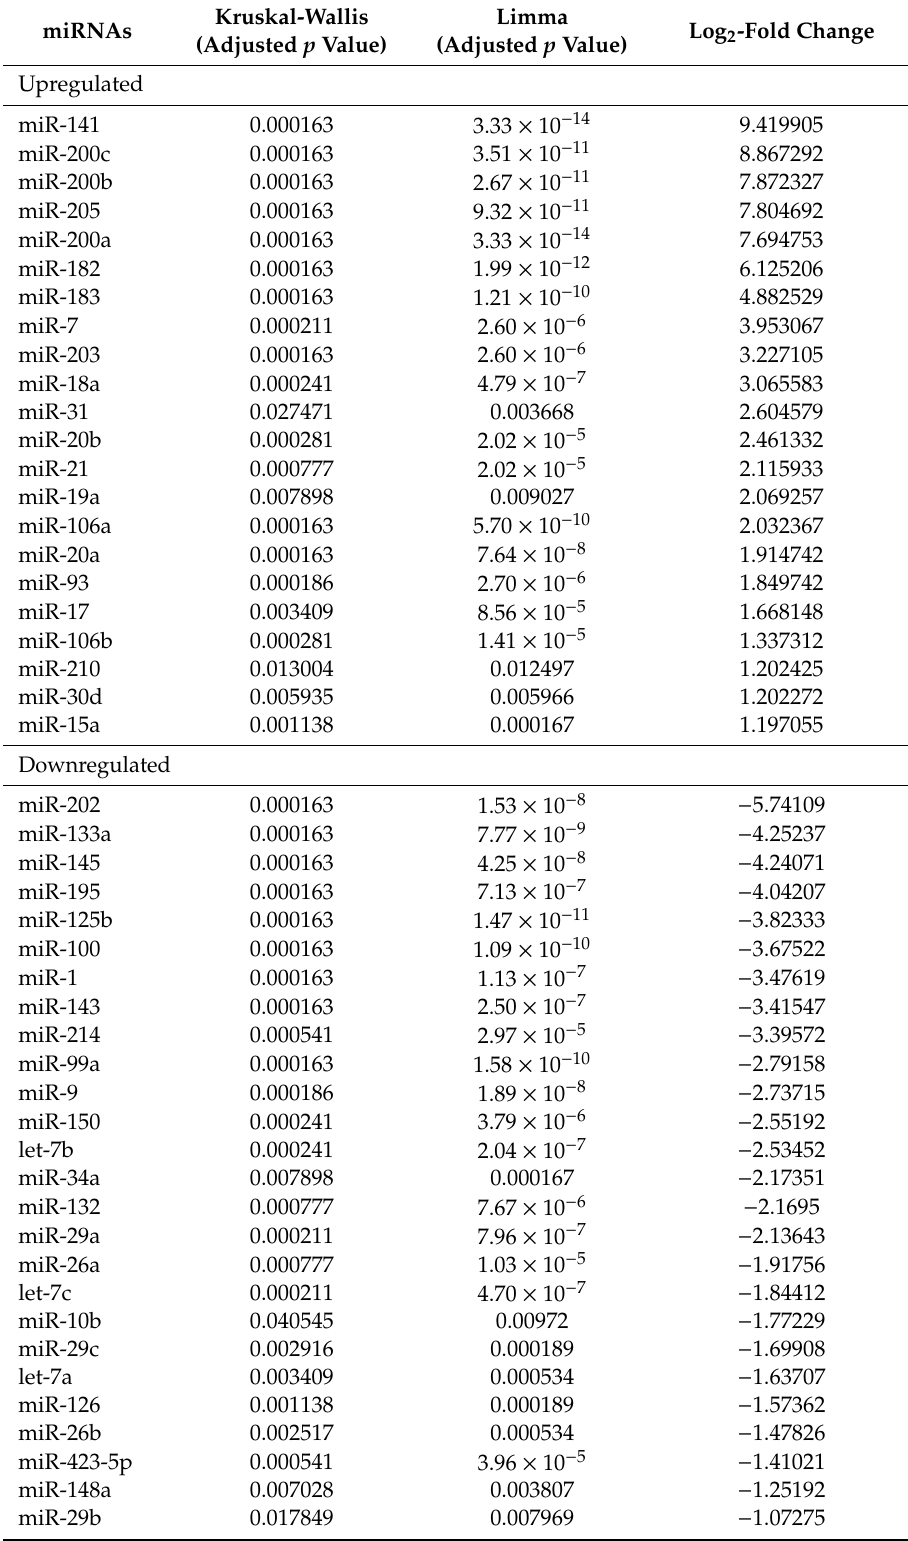
Table 2. The list of di ff erentially expressed miRNAs in metastatic serous ovarian cancer (SOC) compared to